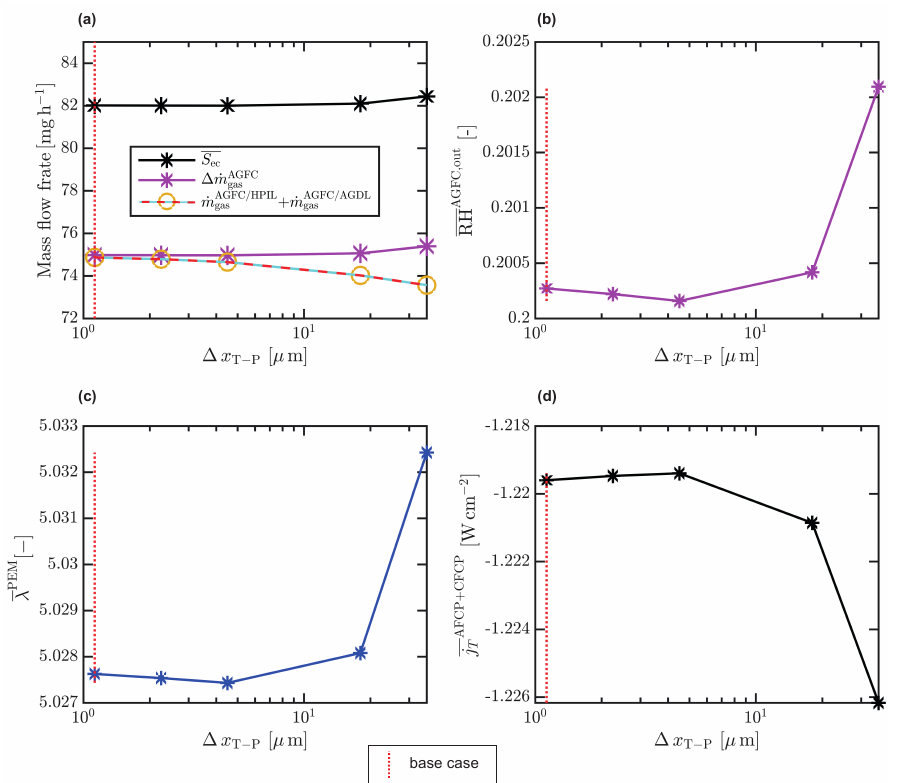
Figure A2. Key output parameters as defined in Table A5 as a function of the through-plane thickness of the first finite element below the AGFC/HPIL interface ∆ x T − P : ( a ) integrated evaporation rate and mass flux; ( b ) average relative humidity in the AGFC; ( c ) average dissolved water content in the PEM; and ( d ) average total heat flux across the anode and cathode FCP ends. All results are evaluated at χ = 10.